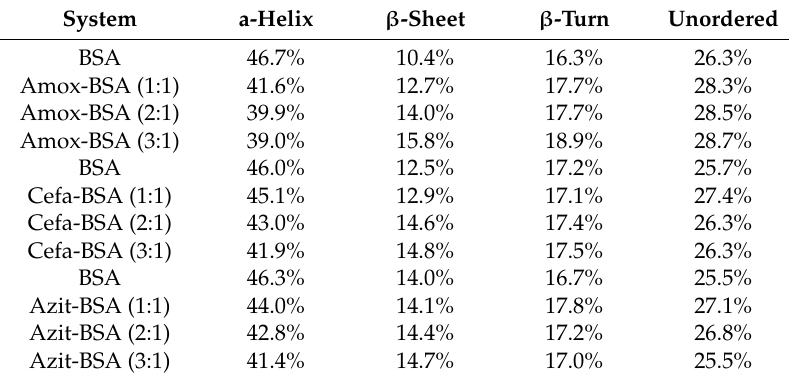
Figure 2. The circular dichroism (CD) spectra of bovine serum albumin (BSA) with and without Amox ( a ), Cefa ( c ), or Azit ( e ) of different concentrations. Changes in the secondary structure content of α -helix and β -sheet in Amox-BSA system ( b ), α -helix and β -sheet in Cefa-BSA system ( d ), and α -helix and β -sheet in Azit-BSA system ( f ). Data in panels b, d, and f are presented as mean ± the standard error of the mean (SEM). Table 1. Secondary structure content of bovine serum albumin (BSA), Amox-BSA system, Cefa-BSA system and Azit-BSA